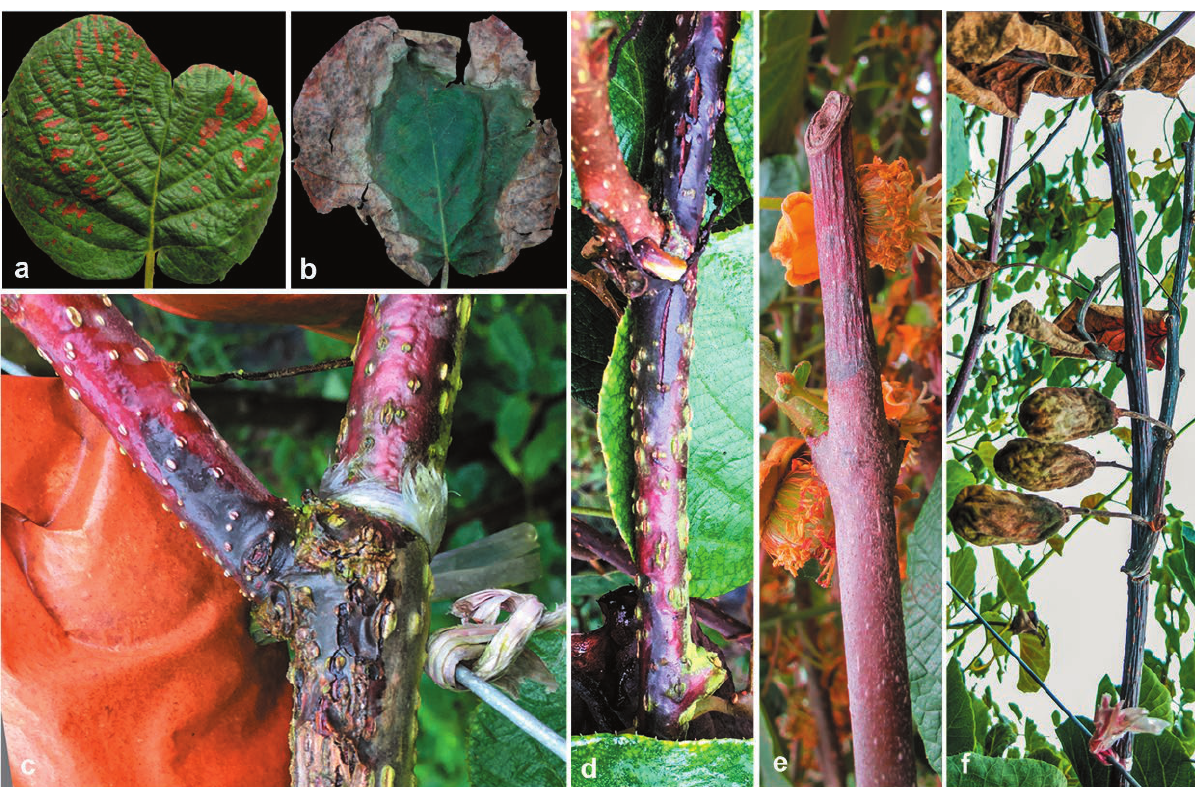
Figure 1. Typical symptoms of kiwifruit leaf spot and shoot blight. a, reddish brown spots on a leaf; b, lesions extend to the margin of a leaf, and small, black pycnidia on the necrotic parts; c, maroon and fusiform lesions on a branch; d, red-black fusiform lesions with internal dis- colouration formed on a branch; e, necrotic lesions spreading on a branch from the pruning wound; f, whole branch